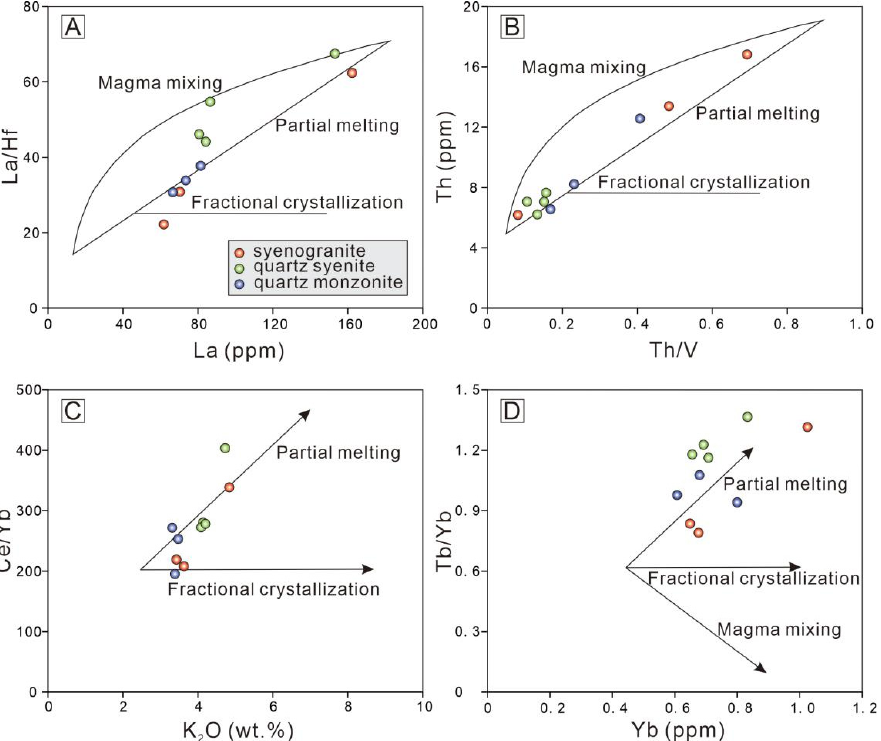
Figure 11. Compositional variation diagrams of ( A ) La/Hf vs. La [45], ( B ) Th vs. Th/V [45], ( C ) Ce/Yb vs. K 2 O [21] and ( D ) Tb/Yb vs. Yb [21] for the alkaline rocks showing partial melting. The alkaline rocks represent Rb/Nb ratios between 2.00 and 9.06 (average 5.07),